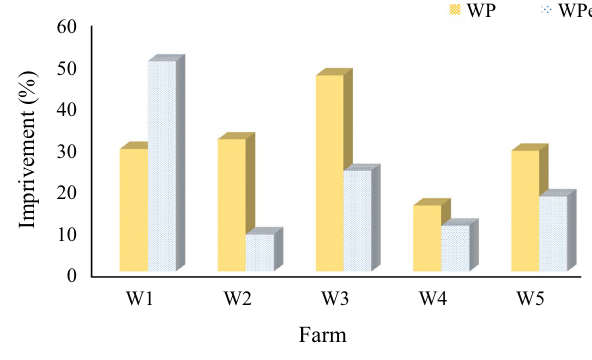
Fig. 9 Effectiveness of agronomic technologies based on WP and WPe